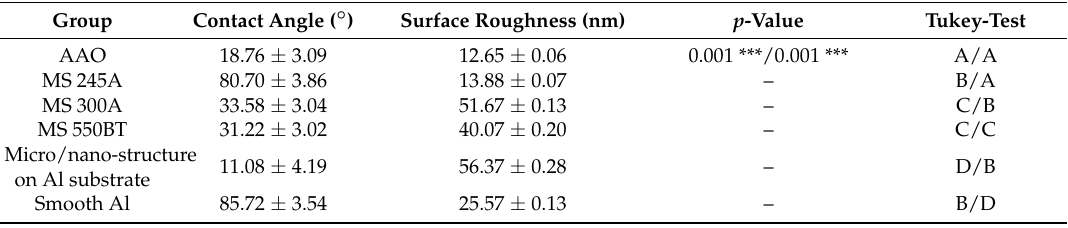
Table 1. Contact angles and surface roughnesses for different structured templates by Tukey-test.